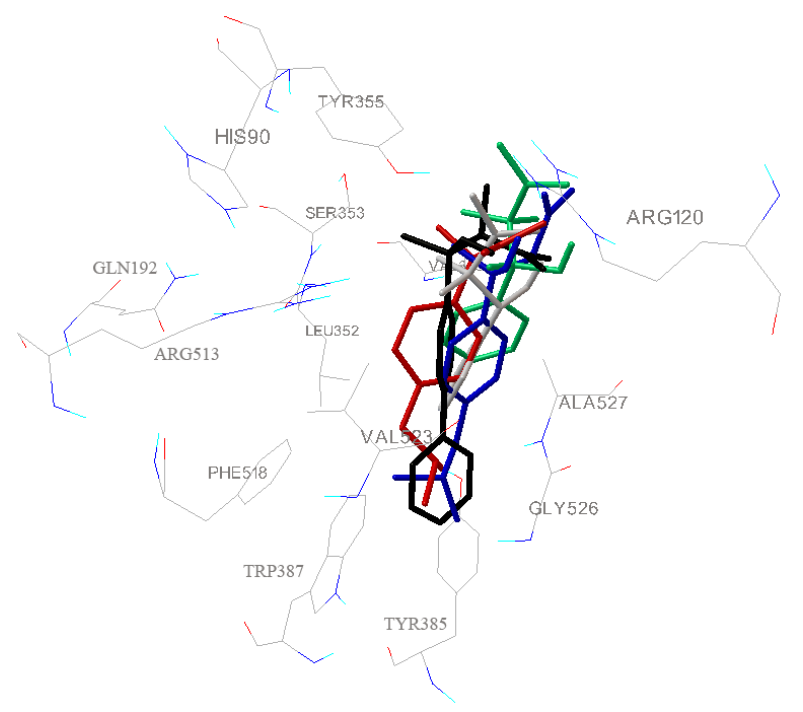
Figure 3 . Superimposition of most favorable conformations of compounds 1 (blue), 2 (green), 4 (gray), 6 (black), and ibuprofen (red) docked into binding site of COX-2 receptor. This image was created using AutoDockTools